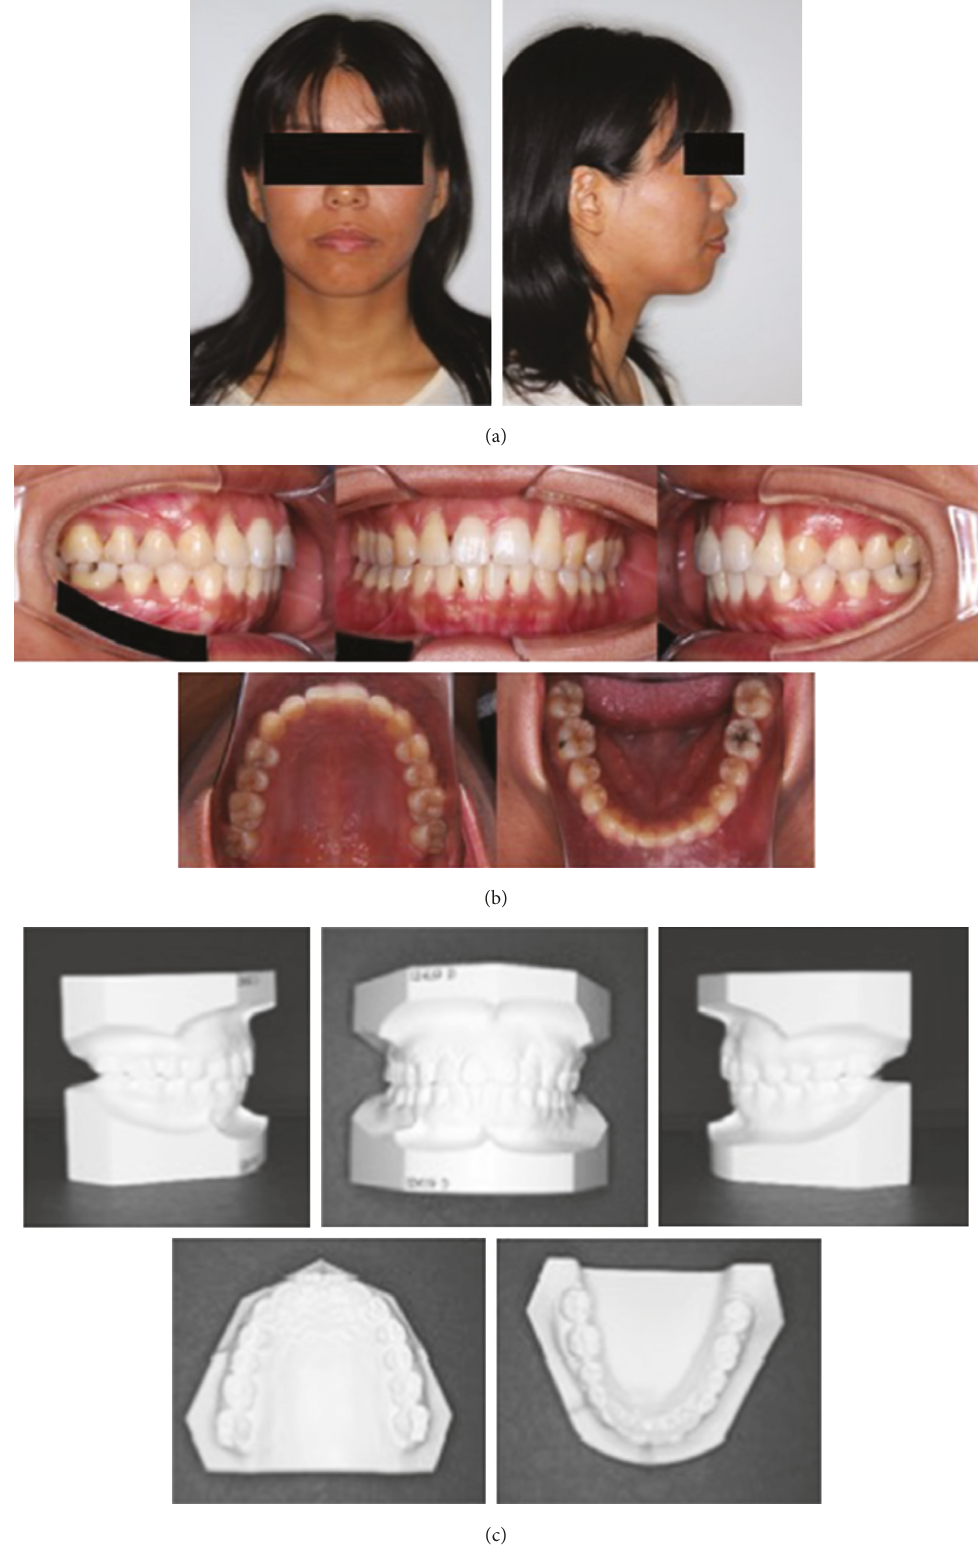
Figure 9: Postretention facial (a) and intraoral photographs (b) and dental casts (c) are